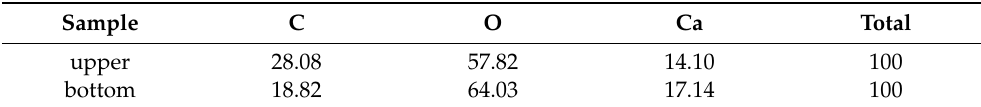
Figure 9. Energy spectrum of the two layers of white sediments. ( a ) upper layer. ( b ) bottom layer. Table 3. Element content of the white sediments.